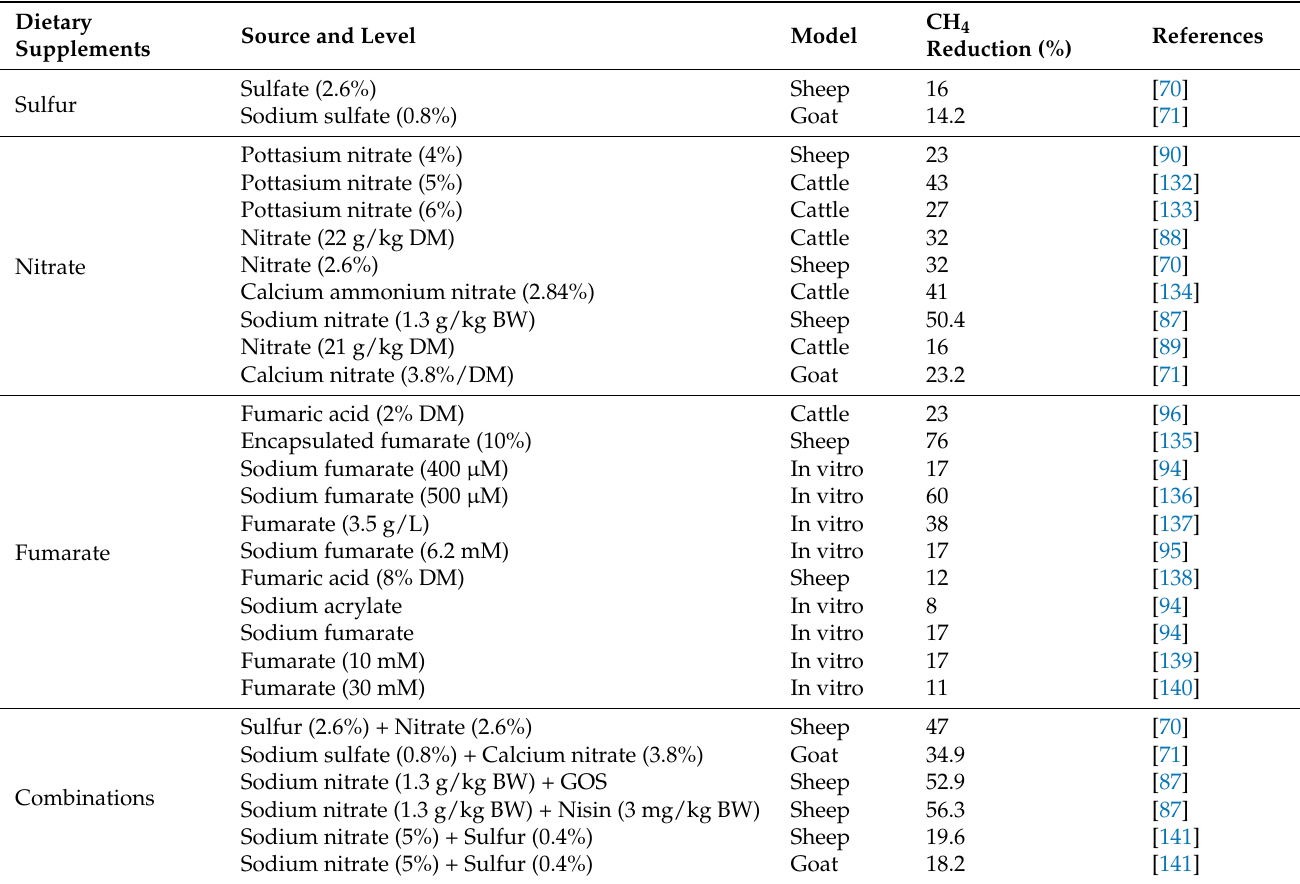
Table 2. Dietary sulfur, nitrate, fumarate and/or combinations on CH 4 production in in vitro or animal